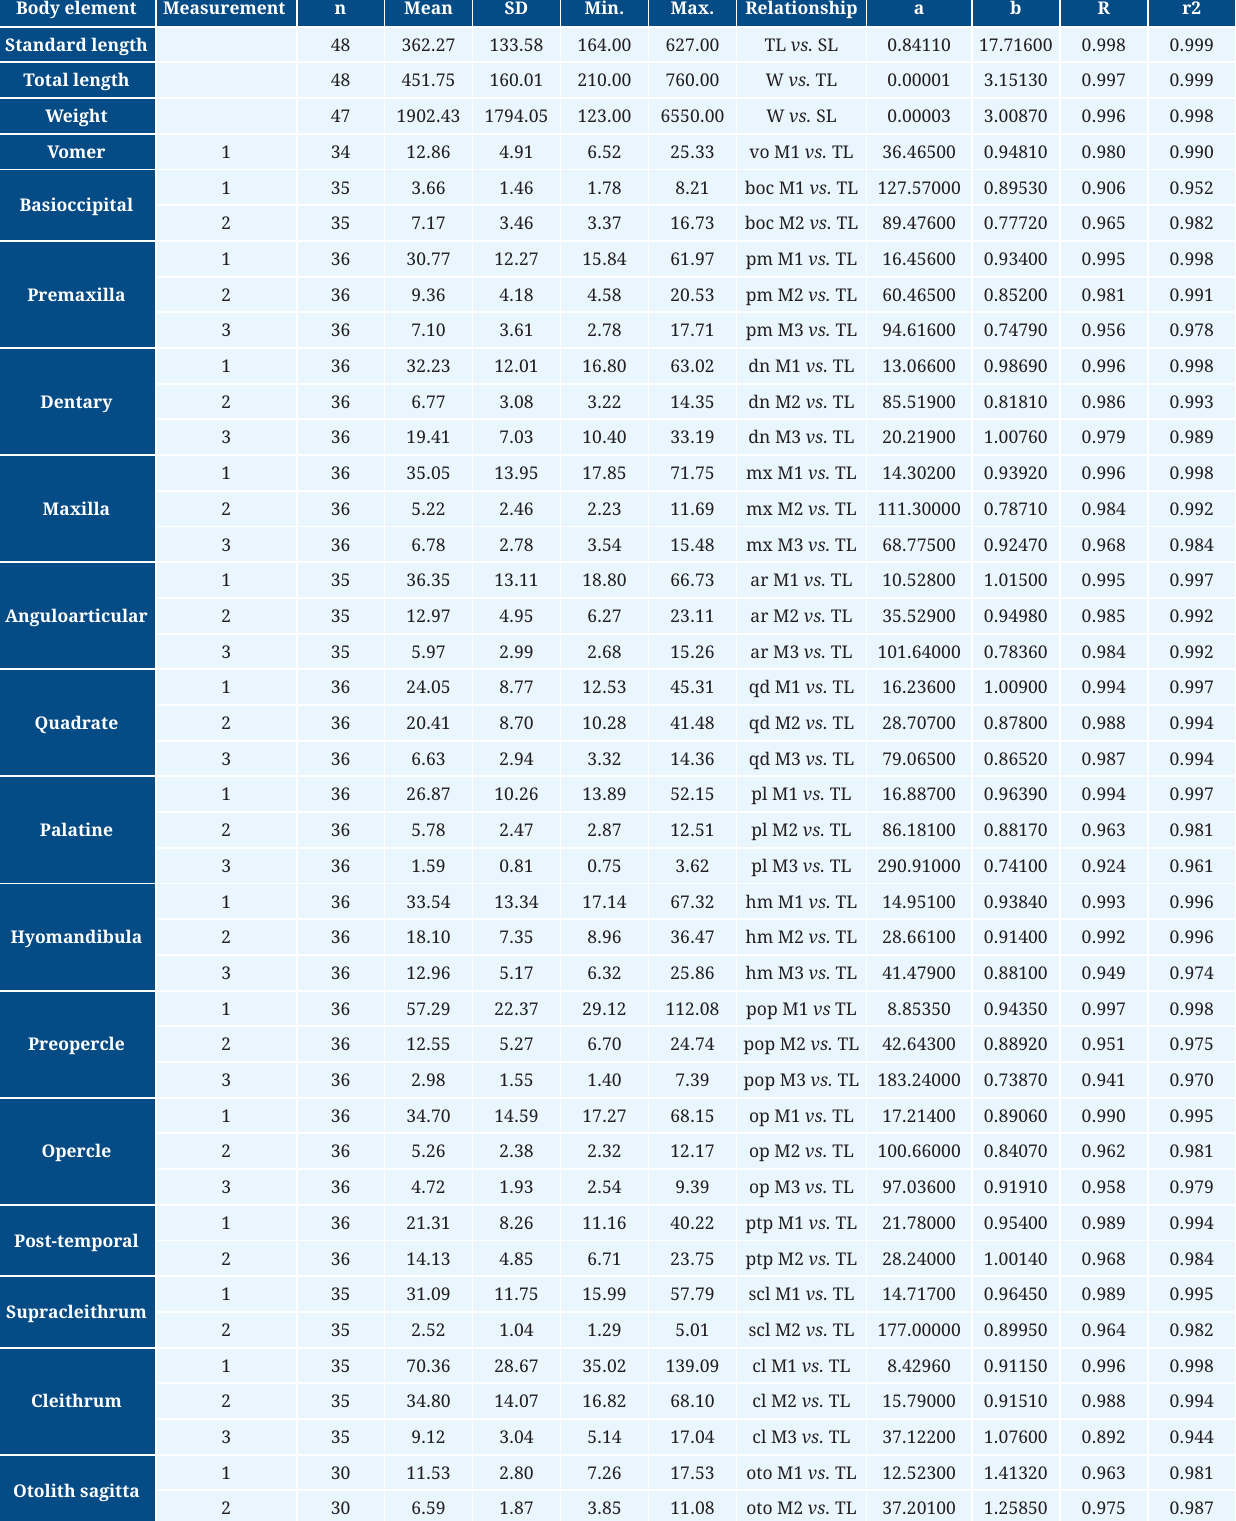
TABLE 2 | Lutjanus argentiventris length to length and length to weight equation parameters (Length in mm and weight in g) (n = 37). Body element Measurement n Mean SD Min. Max. Relationship a Standard